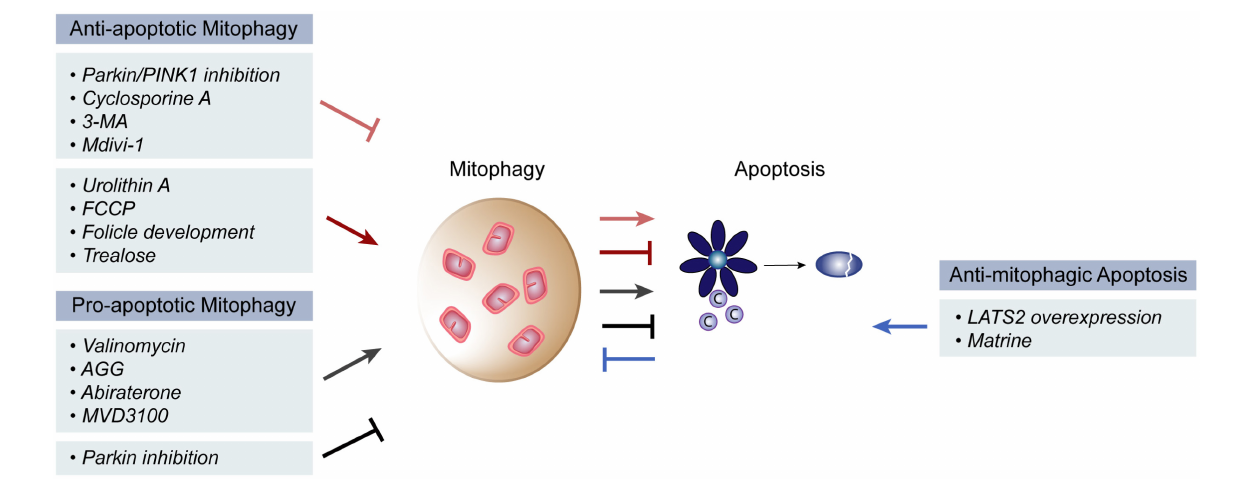
FIGURE 2 | Pro- and anti- apoptotic roles of mitophagy. Mitophagy is reported to both induce and inhibit apoptosis in different physiological and pathological contexts. Inhibition of mitophagy via Parkin/PINK1 inhibition, Cyclosporine A, 3-MA or Mdivi-1 treatment has the ability to induce mitochondrial apoptosis, while induction of mitophagy that occurs during follicle development or upon urolithin A, FCCP or trealose treatment, has the opposite effect. On the other hand, pro-apoptotic roles of mitophagy were described upon mitophagy induction via valinomycin, AGG, abiraterone or MVD3100 treatment. Further, mitophagy suppression by parkin inhibition also inhibited apoptosis. Finally, an anti-mitophagic role of apoptosis could be observed upon overexpression of the large tumor suppressor gene 2 (LATS2) gene or by matrine